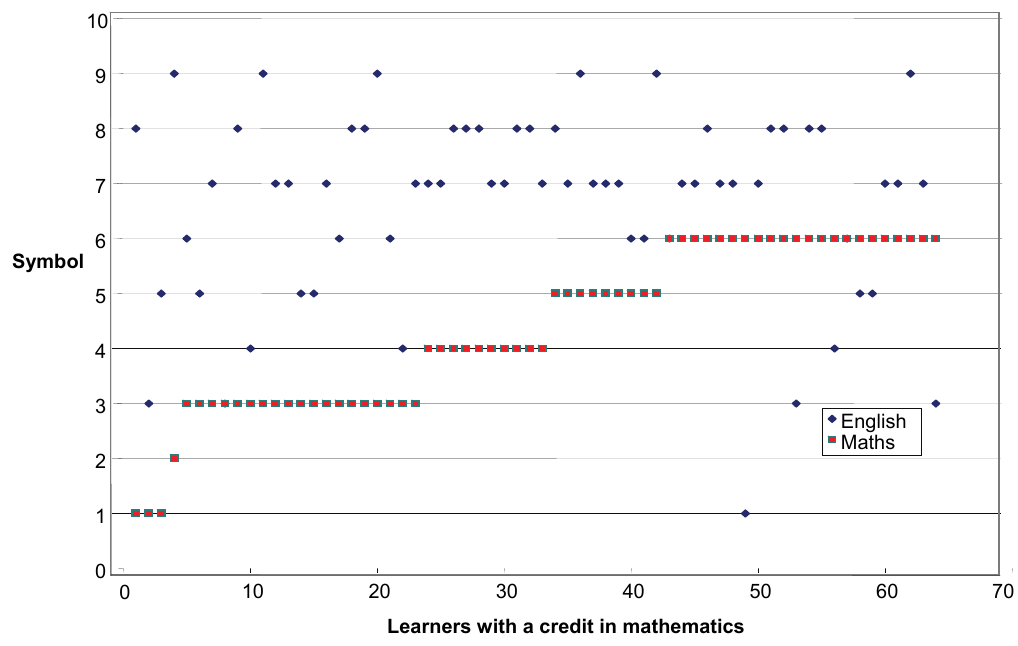
Figure 1: The 2006 English Language and Mathematics grades for BeNguni High School candidates